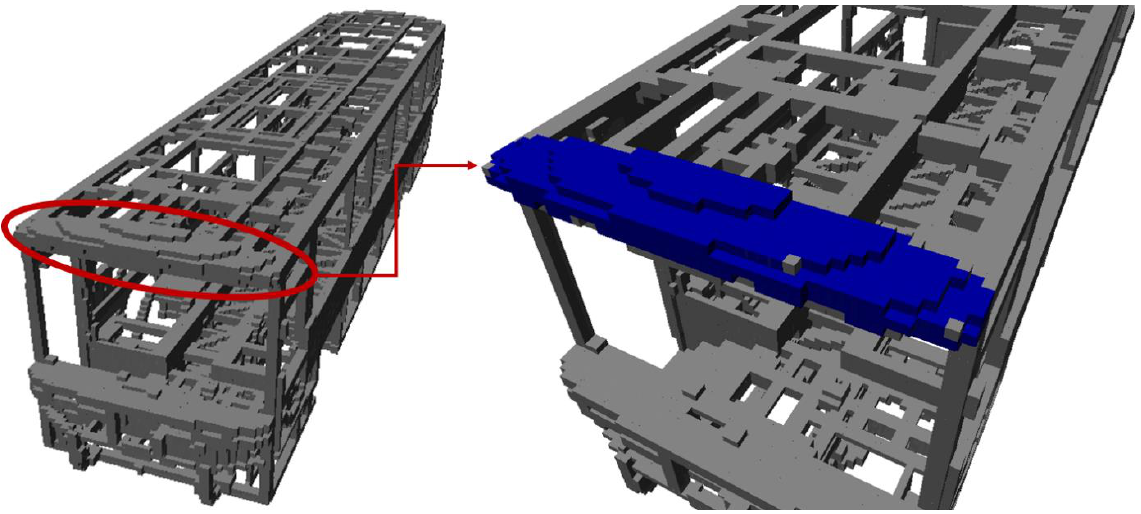
Figure 3. A part of the bus: ( a ) mesh model, ( b ) rendered view, ( c ) point cloud of the part from the bus.